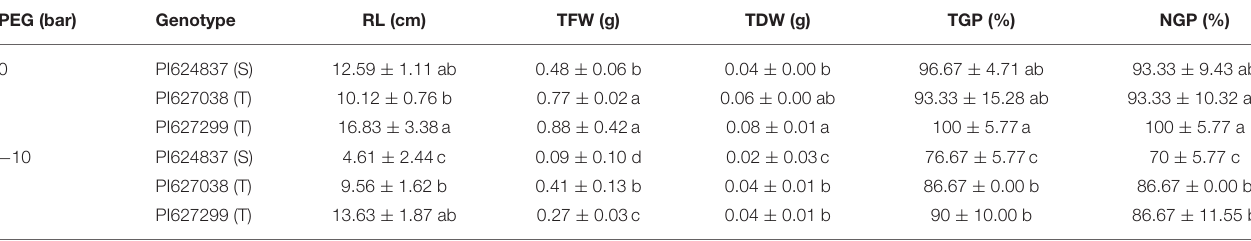
TABLE 1 | Assessment of tolerant and susceptible genotypes according to germination parameters under simulated water deficit using PEG